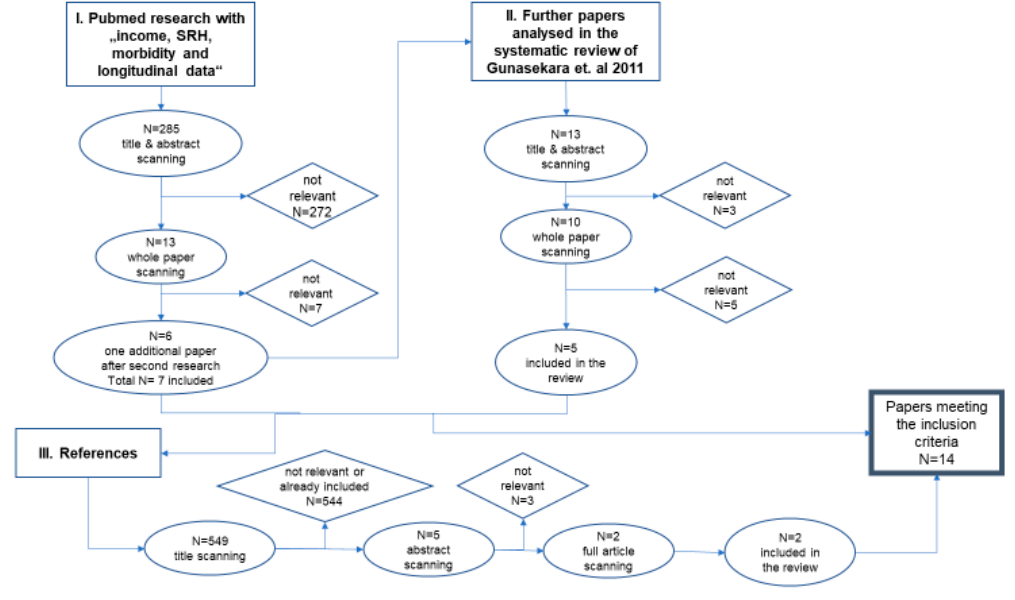
Figure 1. The search strategy.